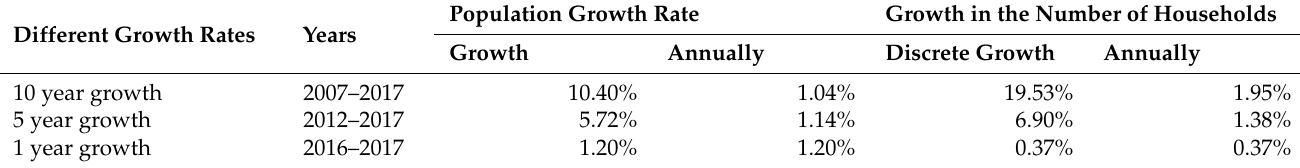
Table 5. The population and household growth rates for Local Municipality (LM) EEE. (Source: Own construction from Stats SA data on the Regional Explorer (ReX n.d.) platform, time series only available up to the year 2017).